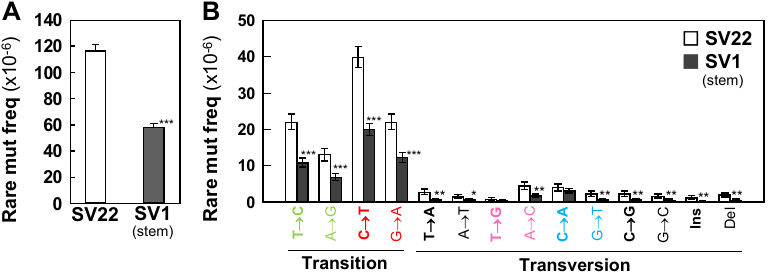
Figure 1. Frequencies of rare mutations in the whole mtDNA. Overall rare mutation frequency ( A ) and frequencies of rare mutation types ( B ) for SV22 (immortalized non-stem) and SV1 (immortalized stem) cells were determined using Duplex Sequencing. Error bars represent the Wilson Score 95% confidence intervals. Significant differences in rare mutation frequencies between two groups are indicated (* p < 0.05, ** p < 5 × 10 −4 , and *** p < 5 × 10 −10 ) by the Chi-Square test.